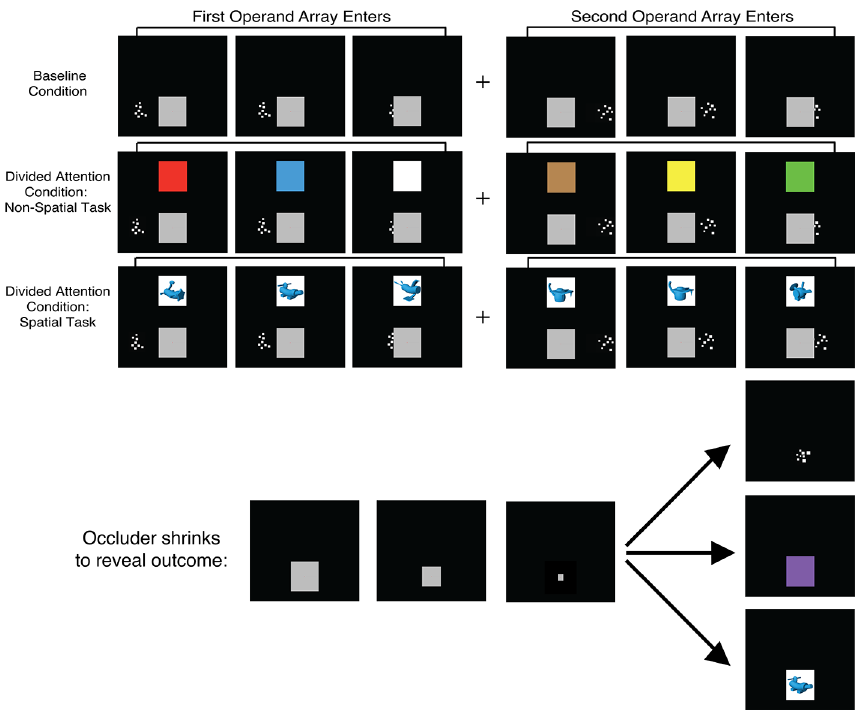
Figure 1. Schematic of an 8 + 8 trial for each